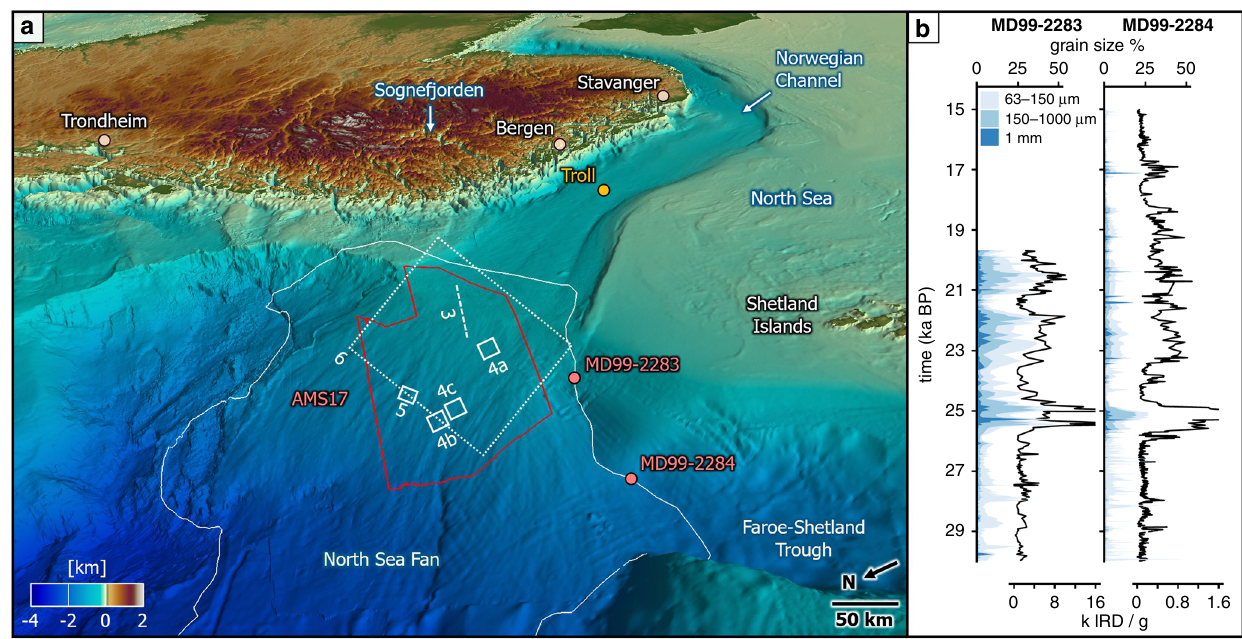
Fig. 2 Oblique view of the bathymetry of the North Sea Fan. a The extent of the high-resolution processed 3D seismic data (red line) and the North Sea Fan (white line) are outlined. Locations of the piston cores (red dots), Troll 8903 borehole (yellow dot), seismic pro fi le of Fig. 3 (dashed line) and maps of Figs. 4 – 6 (white boxes) are shown. Vertical exaggeration is 25× for offshore and 2.5× for onshore domains. Scale bar approximate for central part of fi gure. b Piston cores used for age correlation (modi fi ed after 39 ). Peaks in sand content (grain size >63 μ m) indicate iceberg disintegration. IRD ice-rafted debris counts in thousands.